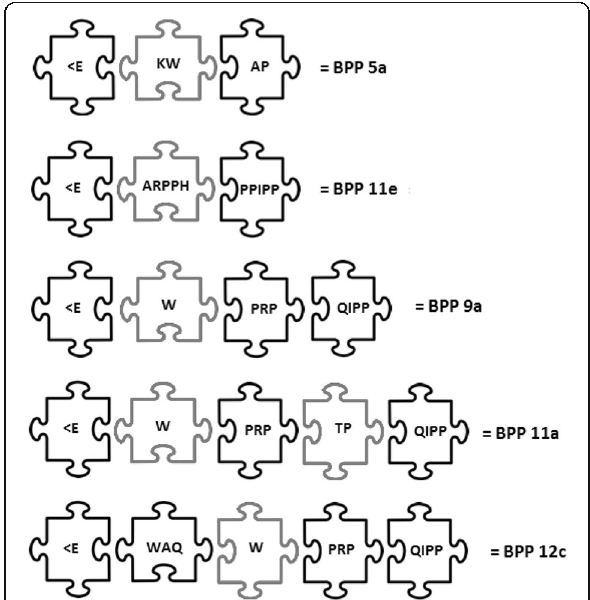
Fig. 1 Actual modular BPPs. In black: mandatory/optional pieces. In grey: additional